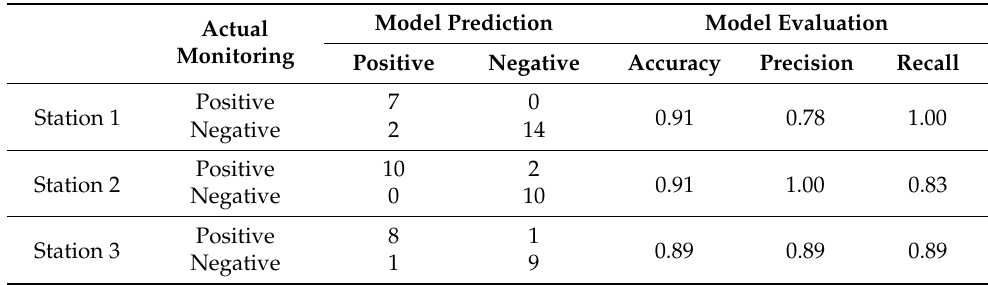
Table 7. The confusion matrix and the evaluation metrics for the spring freshet